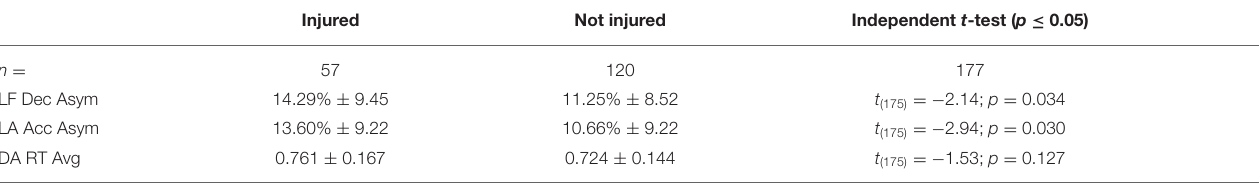
TABLE 2 | Means and standard deviations comparing injured vs. not injured for the final three predictor variables. Injured Not injured Independent t -test ( p ≤ 0.05) n = 57 120 177 14.29% ±